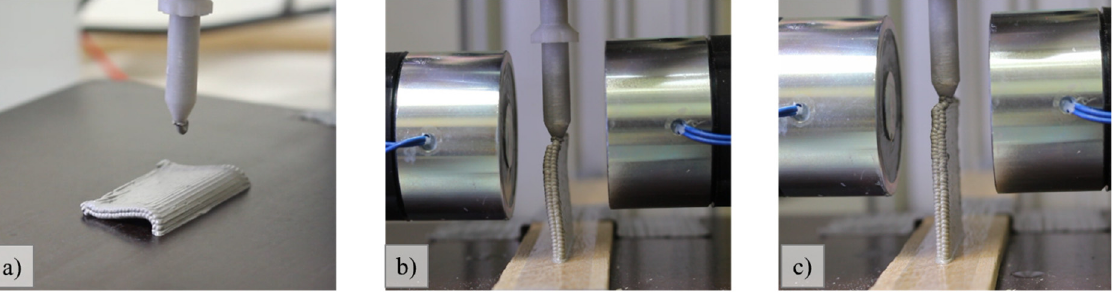
Figure 8. Influence of electromagnets on a test wall: ( a ) without influence (collapse reference value h > ~30mm); ( b ) with electromagnet activated unilaterally (left); and ( c ) with electromagnets activated bilaterally.